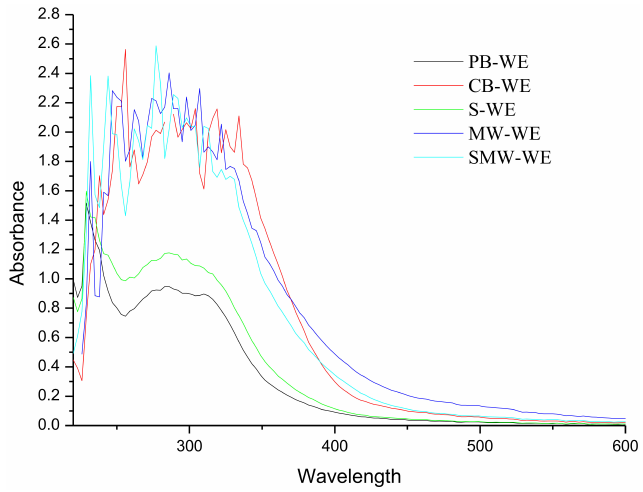
Figure 3. UV-Visible spectra of the extracts showing peaks pertaining to the flavonoids and phenolics present in